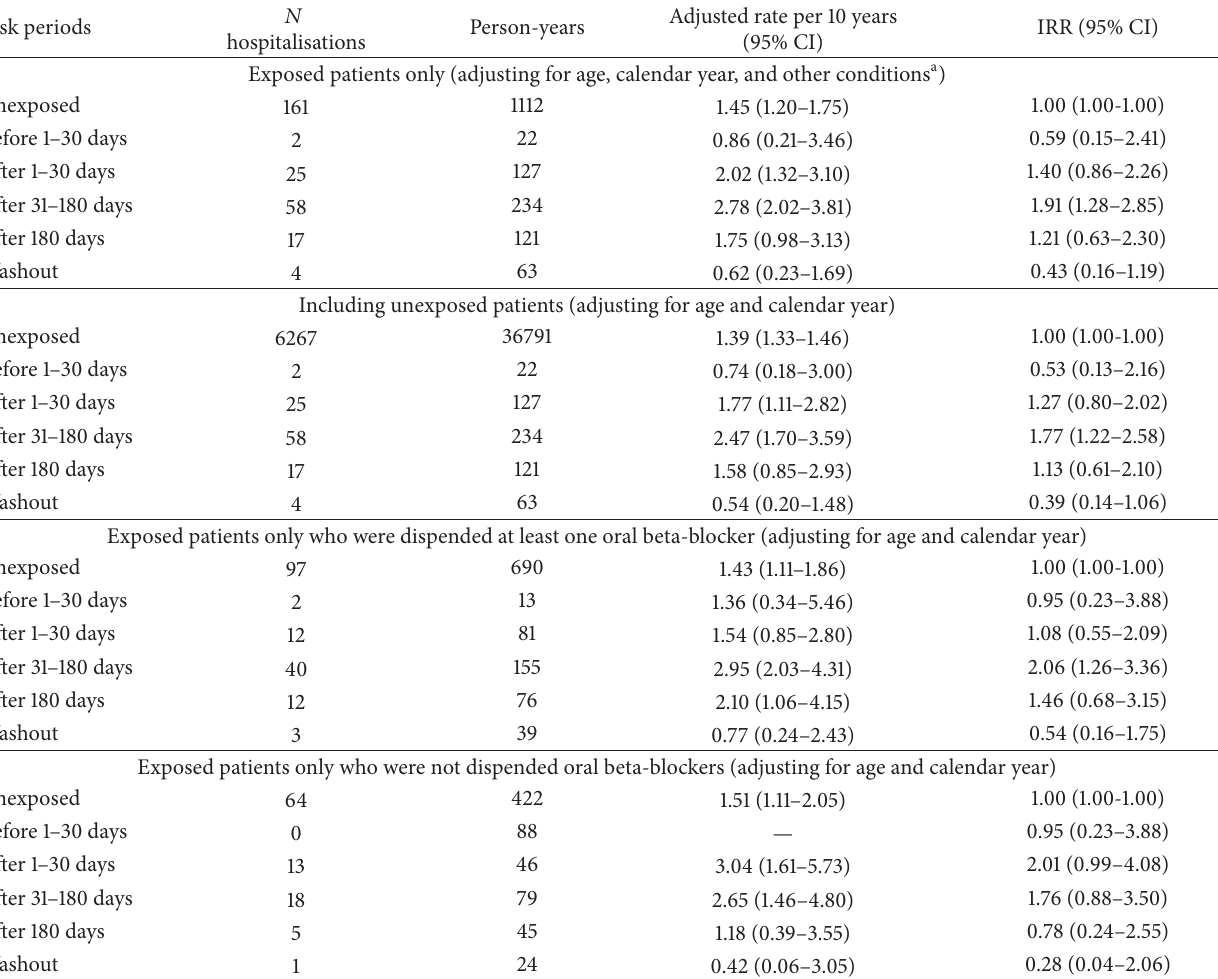
Table 3: Sensitivity